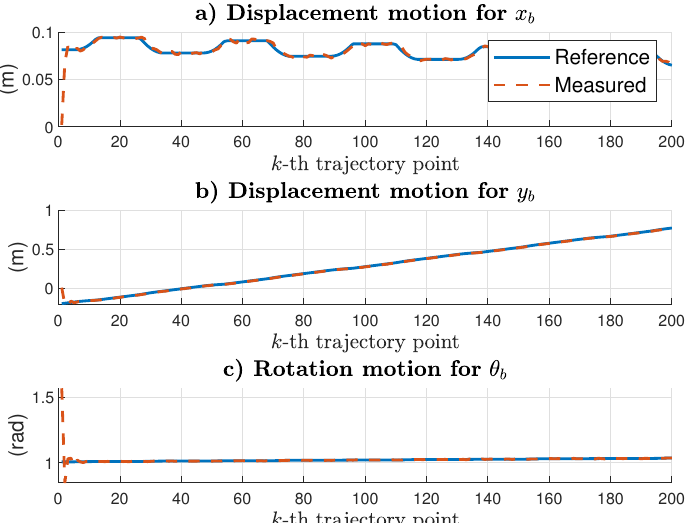
Figure 11. Motion results for the mobile platform. The “Reference” label indicates the optimal pose value provided by the CMA-ES algorithm, and the “Measured” label is the current odometry value.